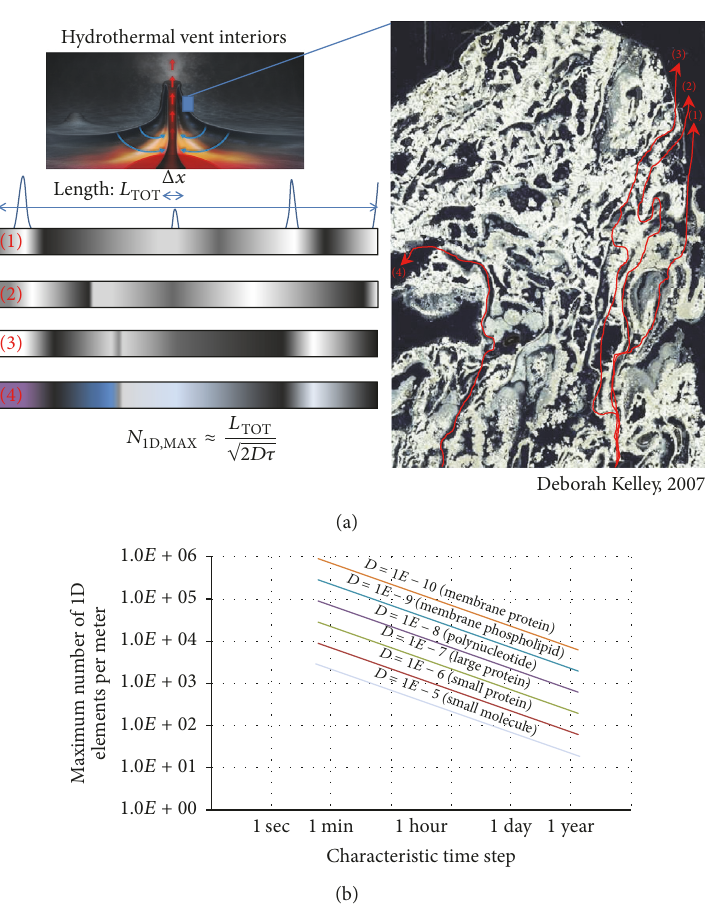
Figure6:(a)Simplifieddepictionofexample1Dmemoryelementsaschamberswithinahydrothermalventchimneycomplex.Whiteshading across horizontal bars (left) corresponds to regions along four different sample pathways through the complex (right) which are net sources of a compound of interest. (b) Maximum number of 1D diffusion-limited memory elements per meter. The width of the lines in plot (b) corresponds to variation caused by temperatures ranging from 20 ∘ C to 250 ∘ C. Vent chimney image modified from original by Deborah Kelley,